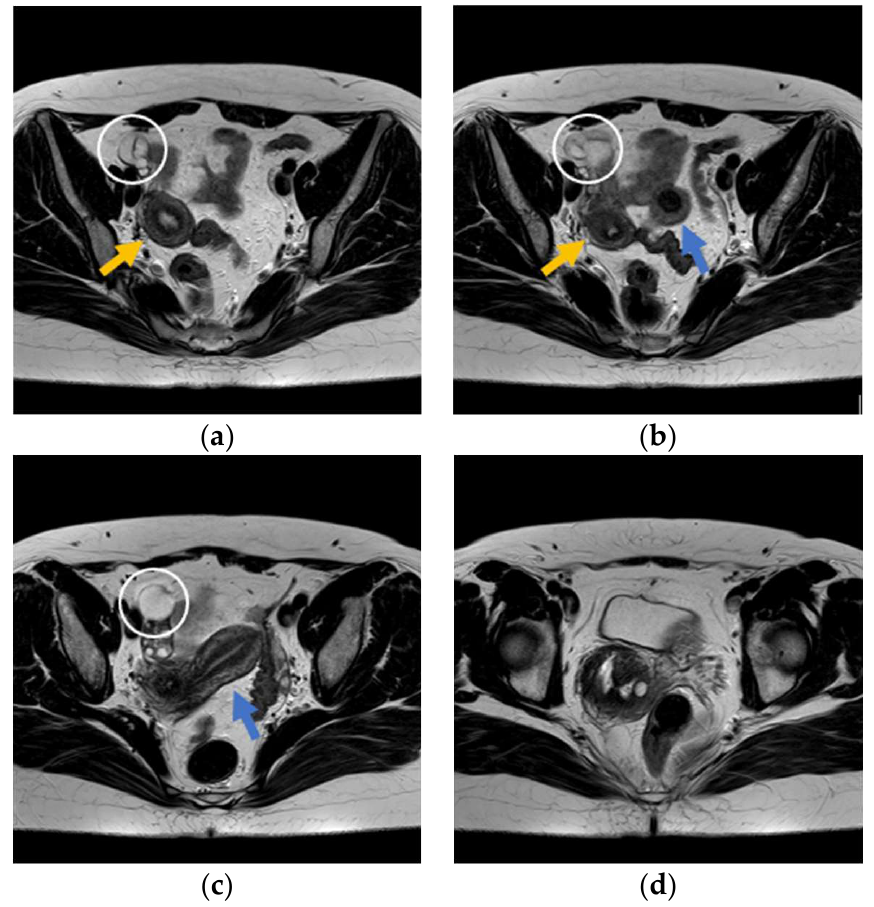
Figure 2. Axial T2-weighted magnetic resonance images (MRI): ( a ) Right hydrosalpinx (white ring) mimicking a multilocular cyst, and right corpus uteri (orange arrow). ( b ) Double corpus uteri, formed separately (orange and blue arrows), and small myoma in left uterus fundus (blue arrow). ( c ) Right hydrosalpinx (white ring) and left corpus uteri (blue arrow). ( d ) Double uterine cervical canal, formed separately.